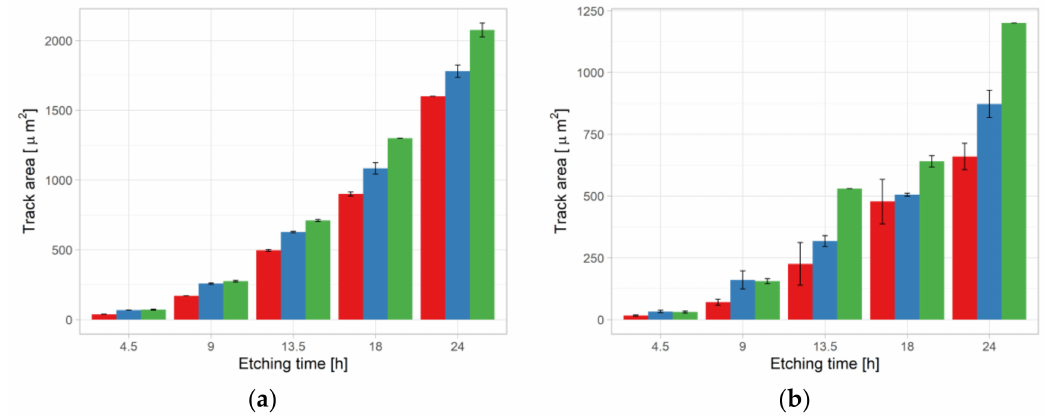
Figure 5. Mean track area vs. etching time for three pre-etching treatments in Experiment 2: 241 Am irradiation ( a ) and radon exposure ( b ). For color codes see Figures 3 and 4.